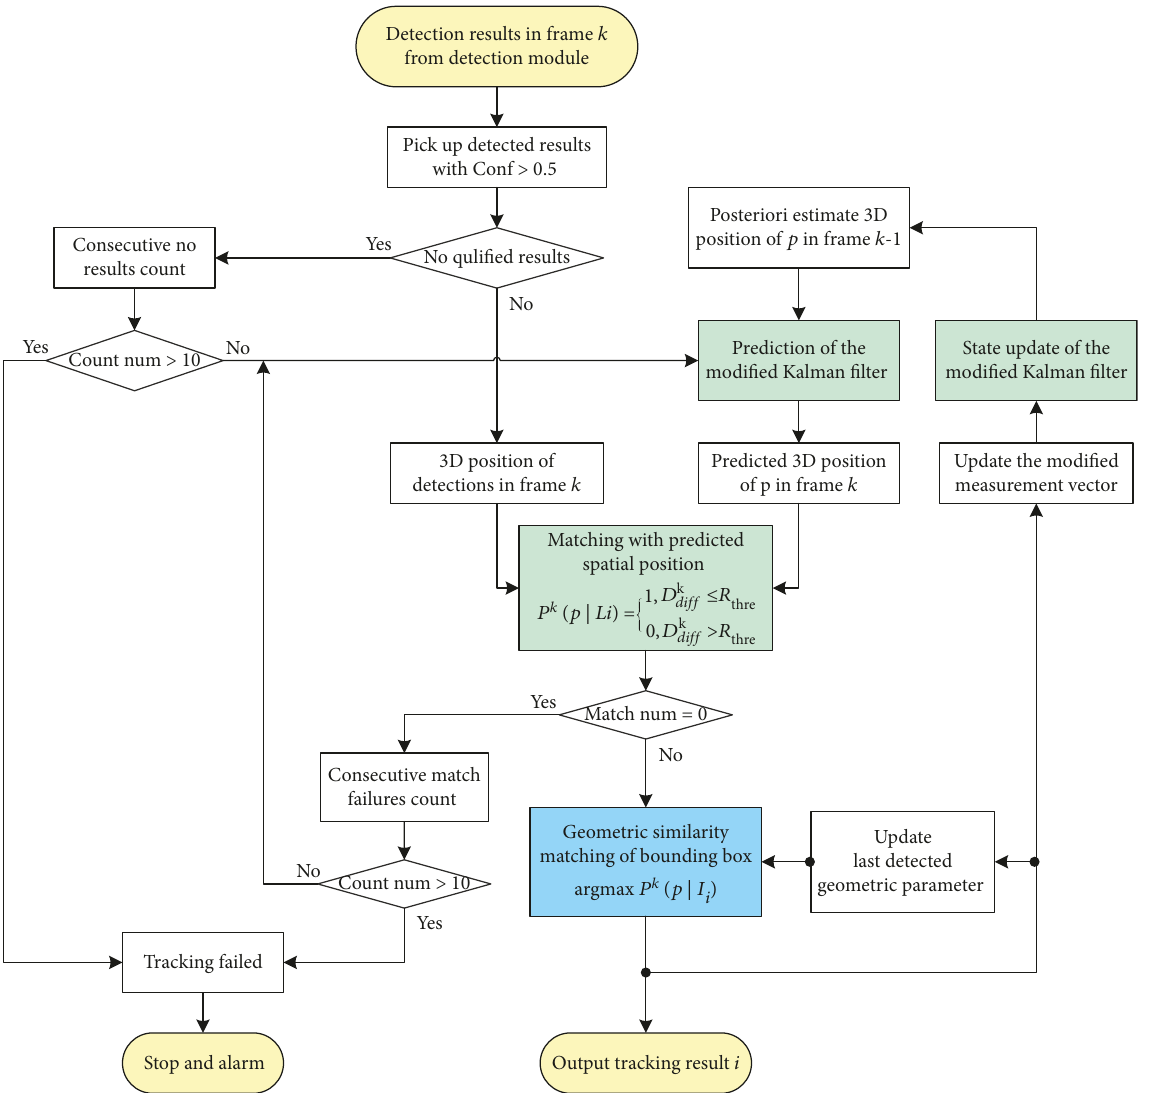
Figure 12: Flowchart of the astronaut tracking